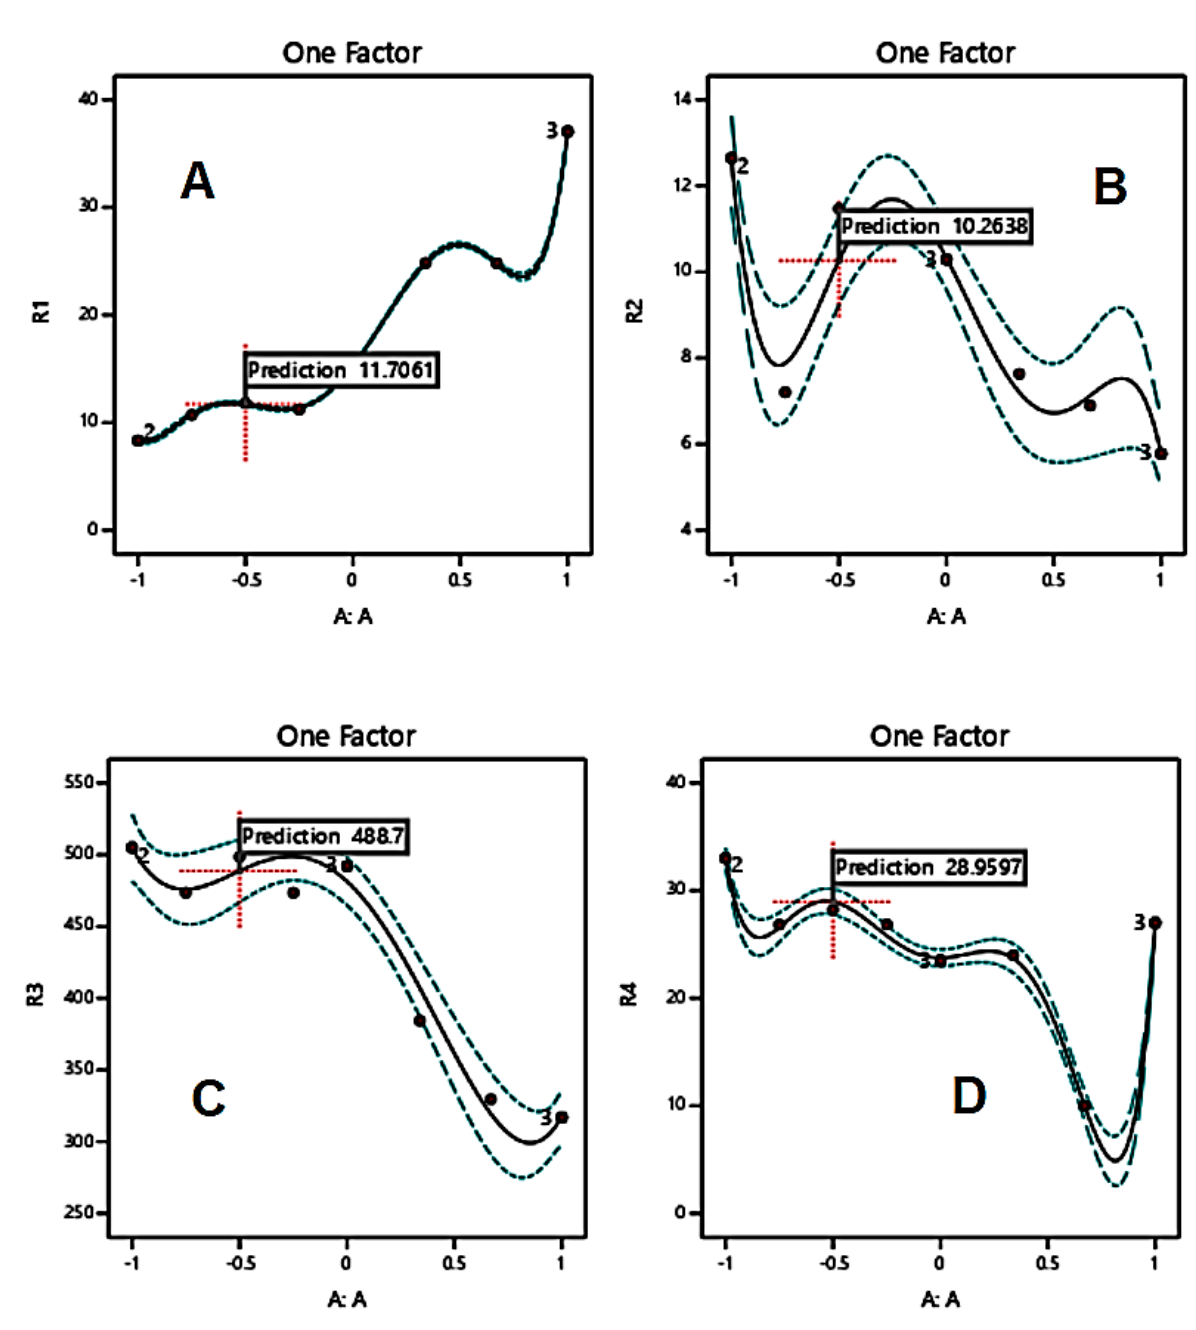
Figure 2. RSM of Mg silicate ‒ starch for a one-factor design with yield pressure ( P Y ) ( A ), P K ( B ), work of compression ( C ), and tablet hardness ( D ) as the responses.